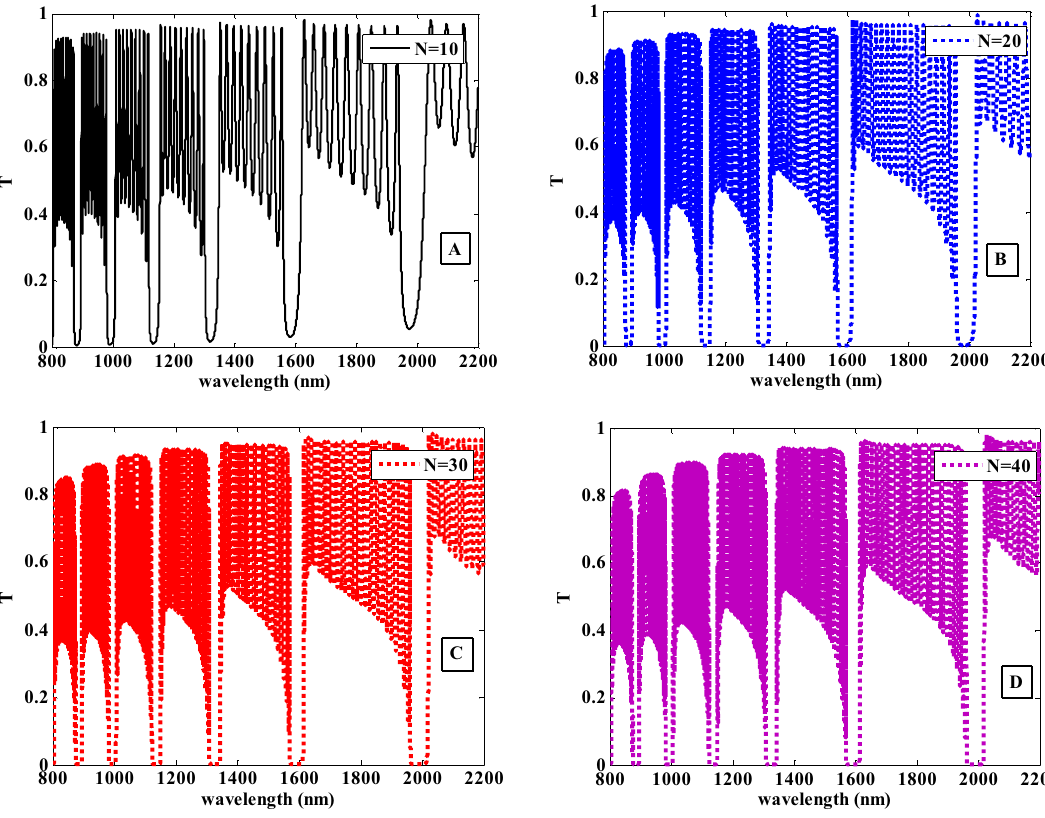
Figure 12. The transmittance spectra of the one-dimensional photonic crystal containing HMM at different values of the number of periods of the structure